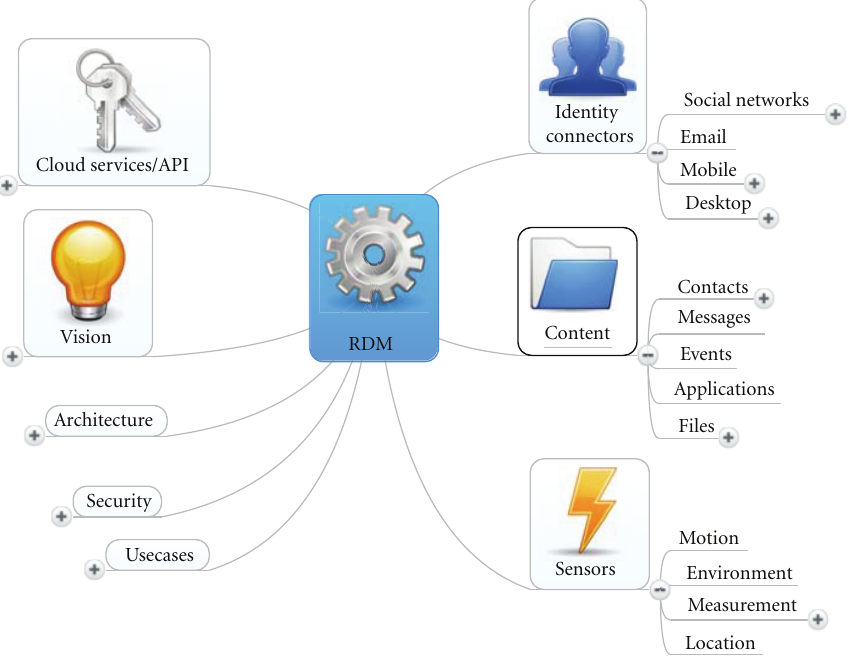
Figure 1: Mind map-Remote Device